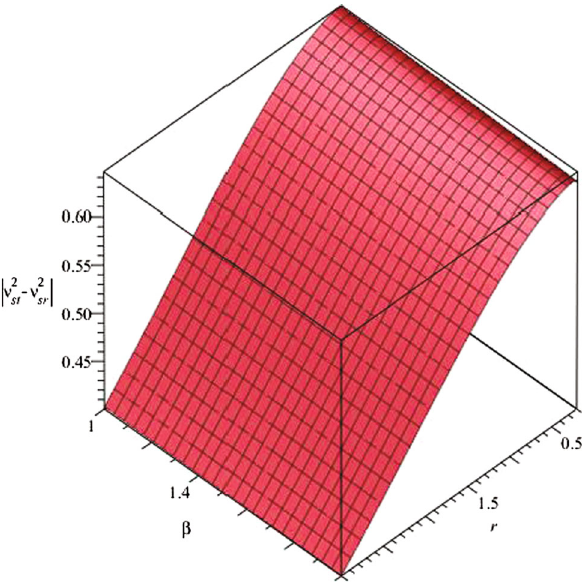
Fig. 3 Plots of | ν 2 st − ν 2 sr | against r and β using M 0 = 1 M (cid:9)